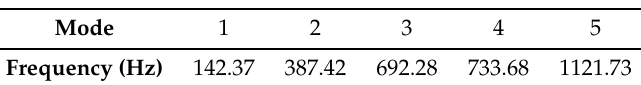
Figure 4. Axle model for modal analysis. Table 2. Natural frequencies.